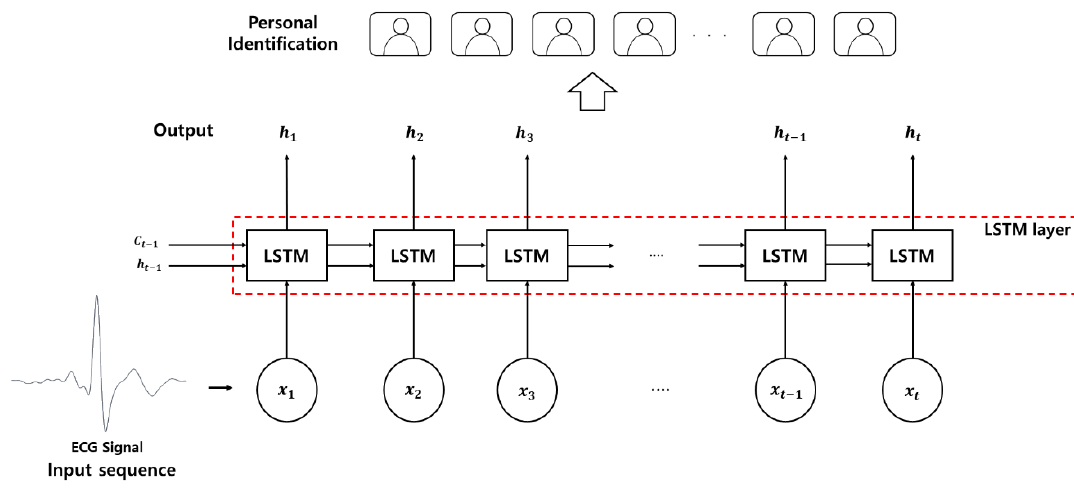
Figure 4. One LSTM layer.